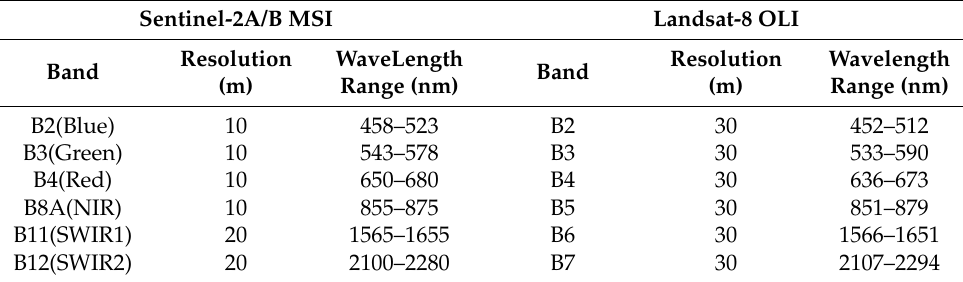
Table 1. Detailed parameter comparison of the OLI and MSI spatial